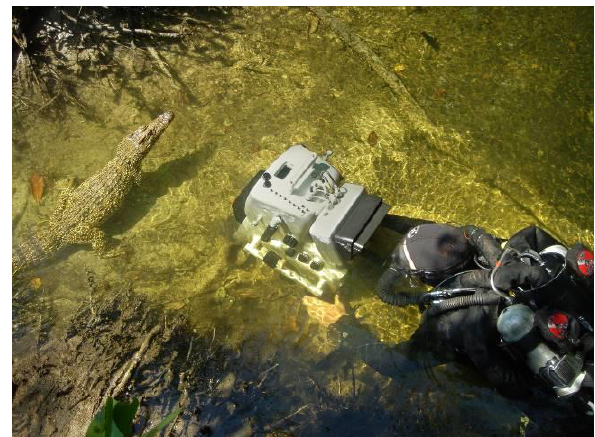
Figure 7. The system we produced is versatile and handily. It was possible to reach very remote environments and freely approach wild animals. As we can see in this image, also working in muddy waters (such as mangrove forest) was possible thanks to the dome port and the wide angle. After that, I have used the system many times and for many movies. At least 4 documentaries of 52 minutes each for Discovery Channel have been produced, as well as a cinema movie produced by Paramount and Orange FR. Several short documentaries for big and medium screen have been realized for museums and marine